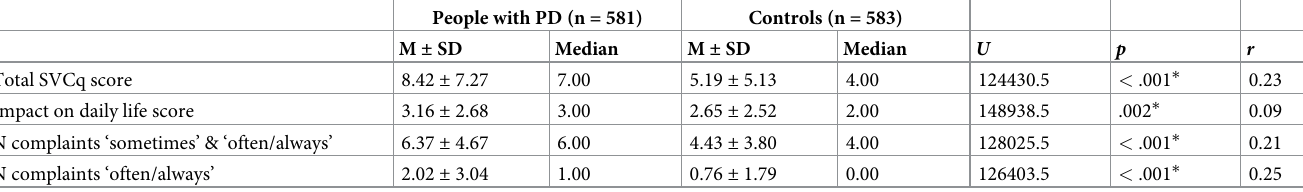
Table 4. SVCq scores of people with PD and the control group, with Mann-Whitney U test results.